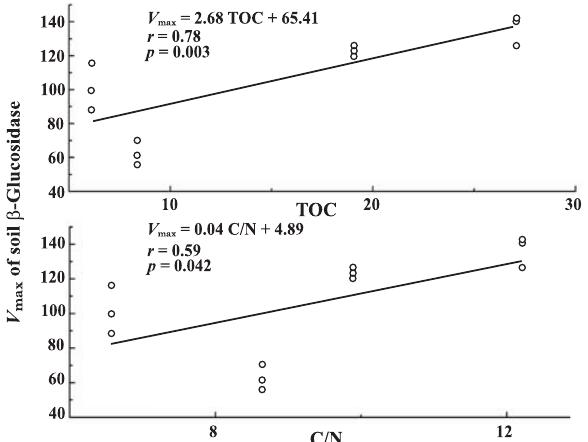
Figure 3. Relationships between Vmax of soil β - glucosidase and soil total organic carbon (TOC) and C/N